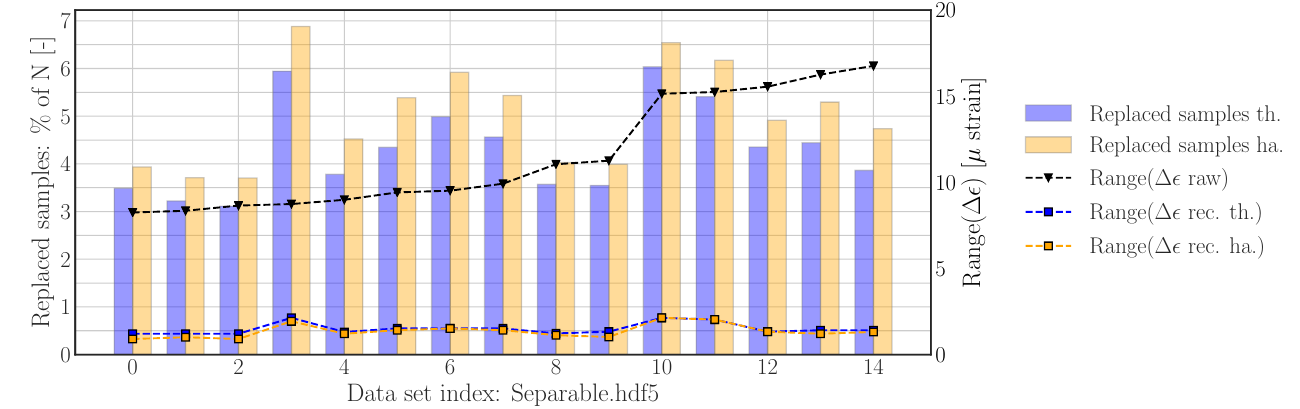
Figure 11. Reconstruction results using threshold filter based method and Hampel filter based method with default settings for data contained in Separable.hdf5 . Left axis : number of replaced samples per file. Right axis : range of sample-wise difference signal before (raw) and after reconstruction